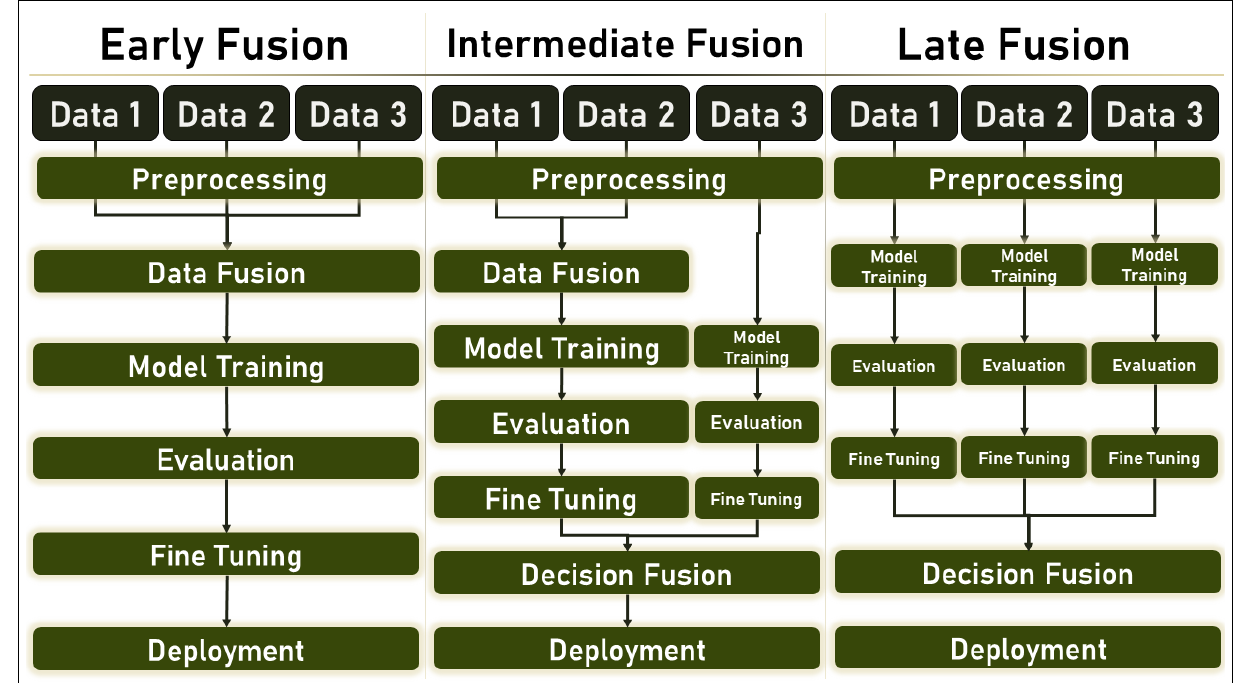
Figure 4. ML workflows based on Multimodal ML